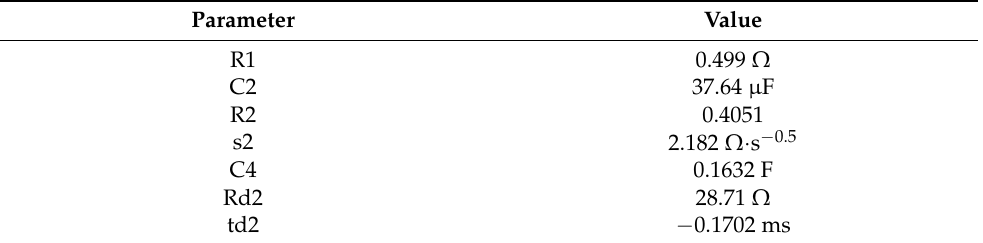
Table 1. Z-fit parameters of the Nyquist plot of Figure 4e.